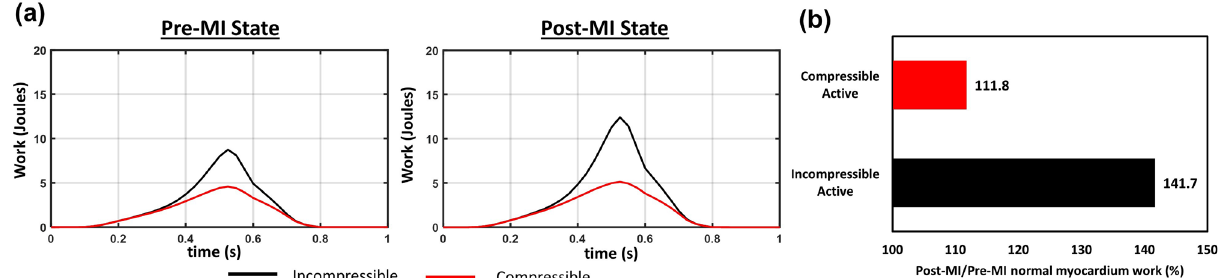
Figure 8. ( a ) Comparisons of work-time relation for normal myocardium between pre-MI state and post-MI state in compressible and incompressible models(black line: incompressible; red line: compressible). ( b ) The post-MI/pre-MI peak work ratio (expressed as a percent) for the incompressible and compressible model for the active